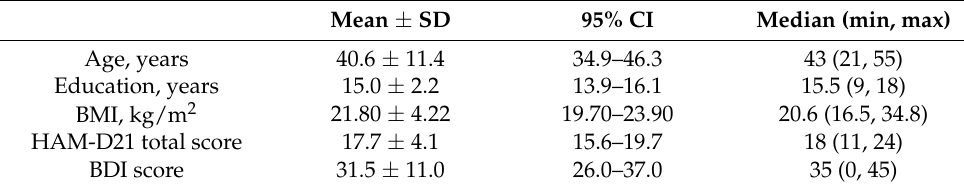
Table 1. Demographic and clinical characteristics of the subjects at